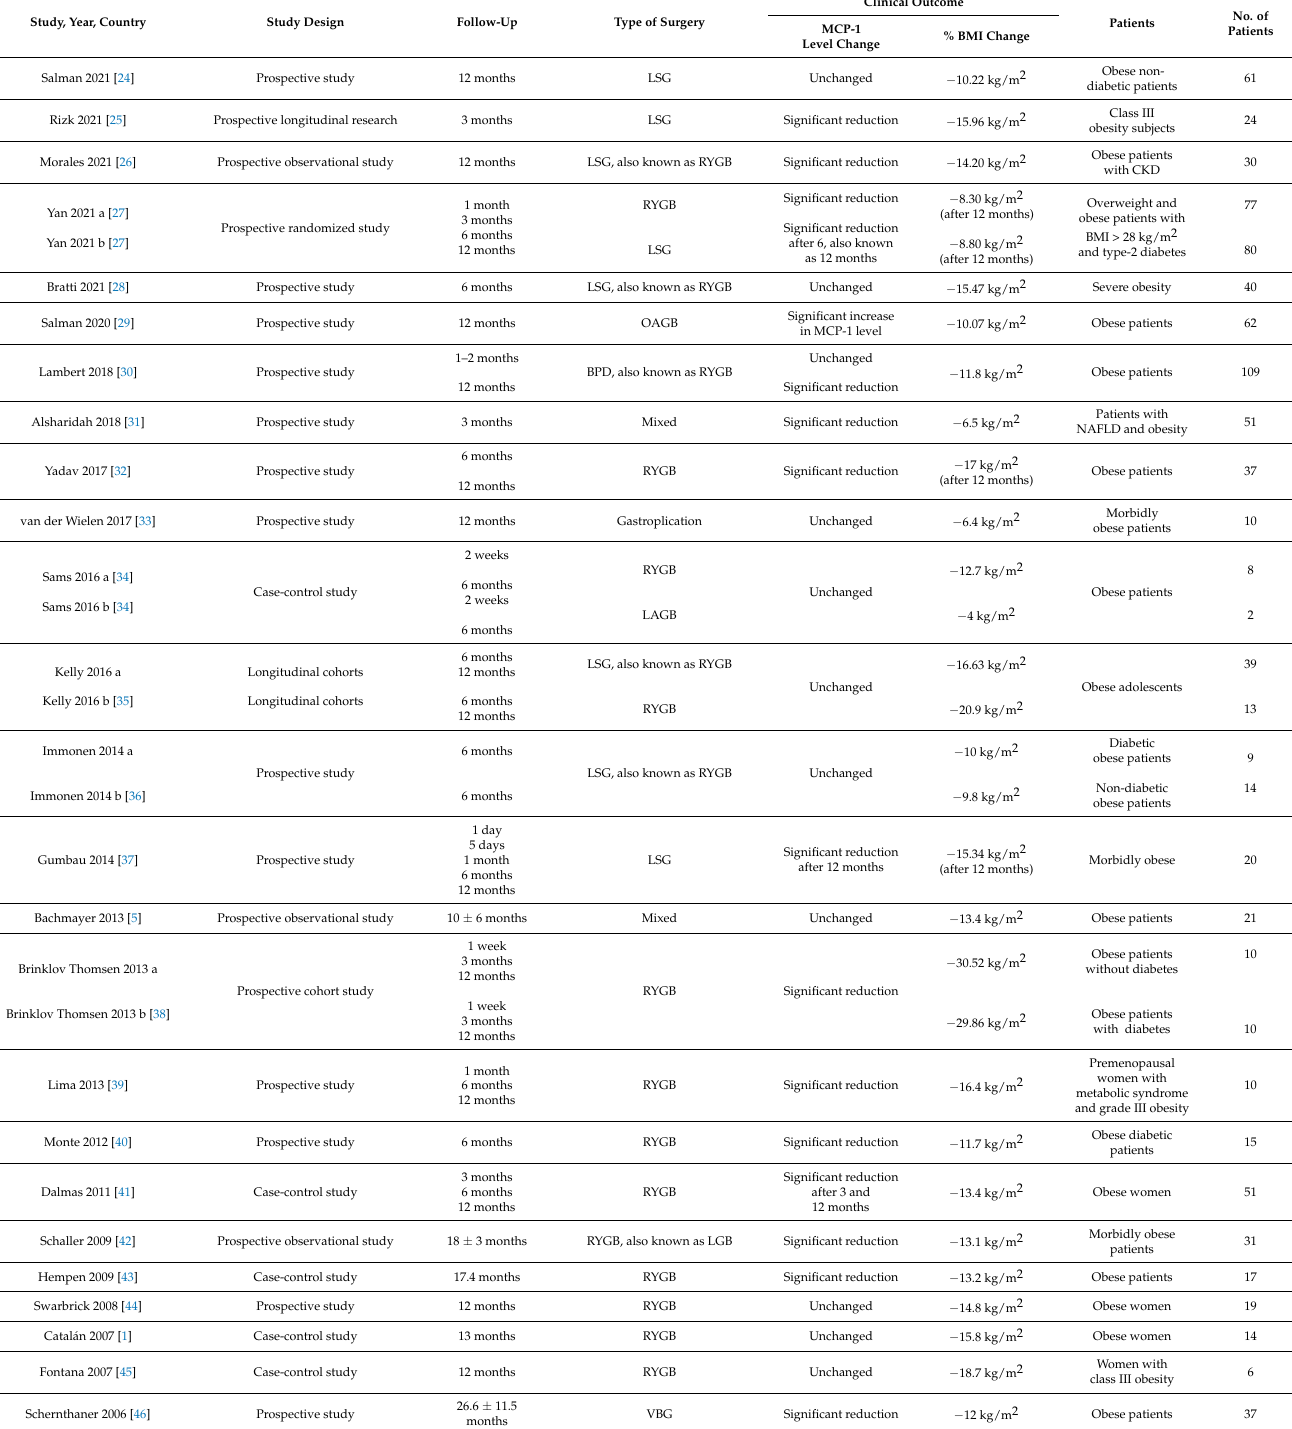
LGB: laparoscopic gastric banding, LSG; laparoscopic sleeve gastrectomy, RYGB: Roux-en-Y gastric bypass, VBG: vertical banded gastroplasty